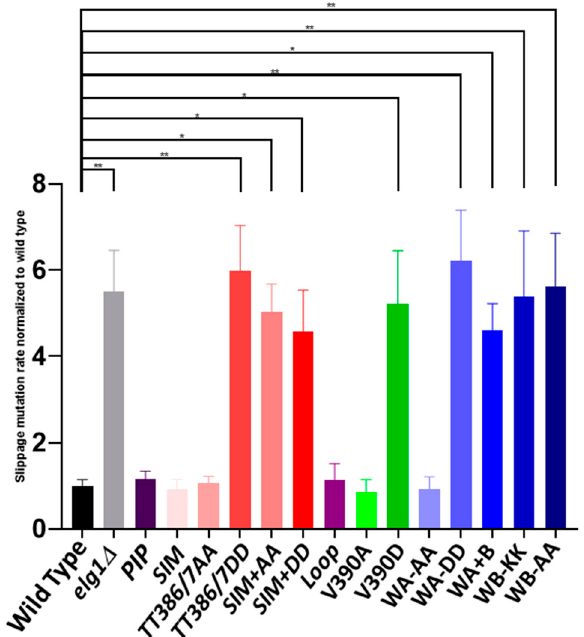
Figure 3. Slippage mutation rates of elg1 alleles. Reversion of the lys2-14A allele was measured by fluctuation test in all isogenic elg1 mutants. The rates were compared to that of the wildtype, which is considered as 1. At least three experiments were used for quantitation and the error bars represent the standard error of the mean. * 0.05 > p > 0.01; ** 0.008 > p > 0.001.